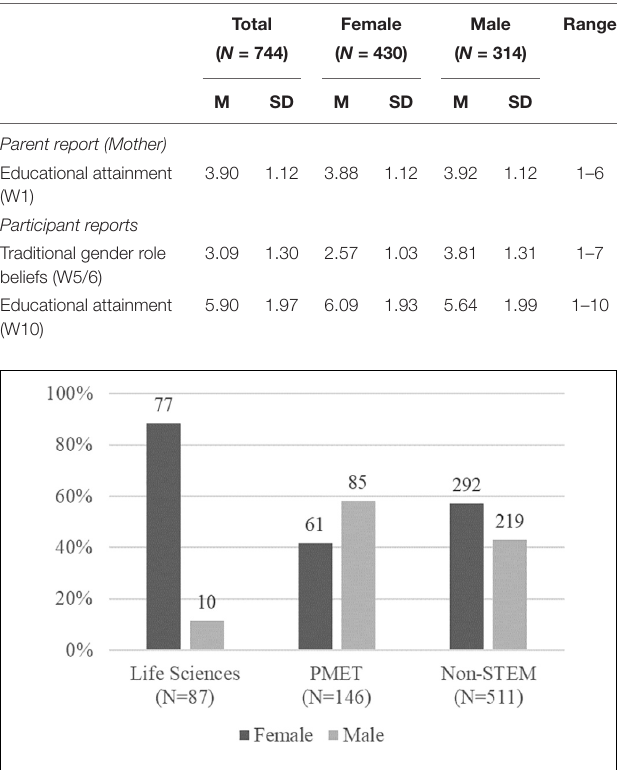
FIGURE 1 | Distribution of STEM-related careers by